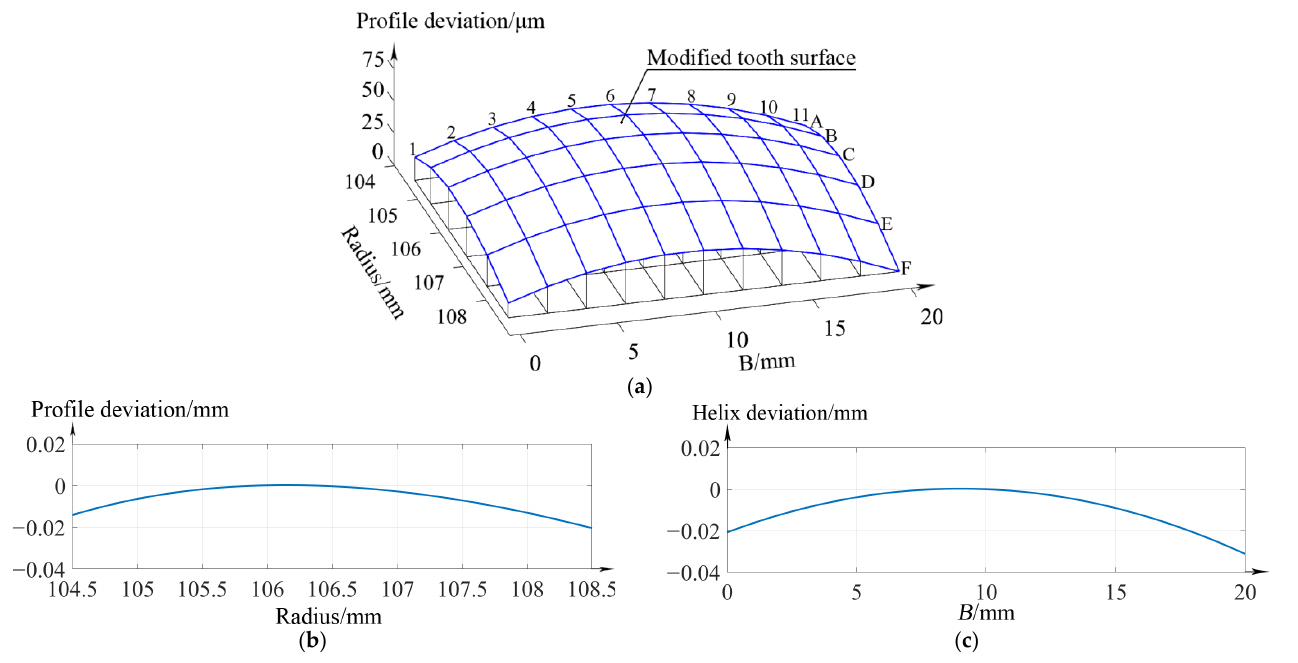
Figure 3. Crowned work gear surfaces. ( a ) topography of the crowned work gear surfaces, ( b ) profile deviation, ( c ) helix deviation. Table 3. Parameters of tooth profile and lead modification. Table 4. Crowning amounts of the crowned work gear surface. (Unit: µ m).